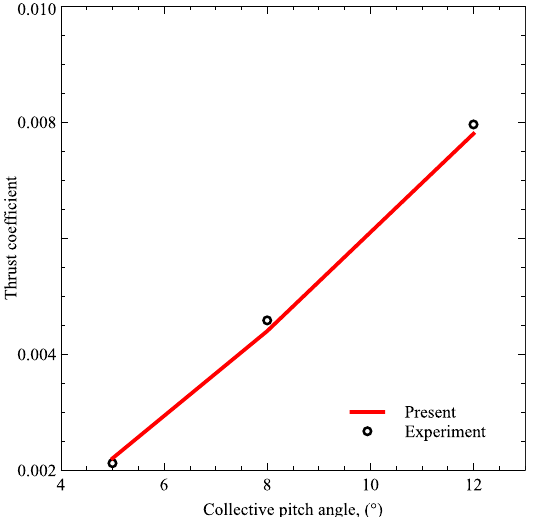
Figure 7. Thrust coefficient at different collective pitch angles.